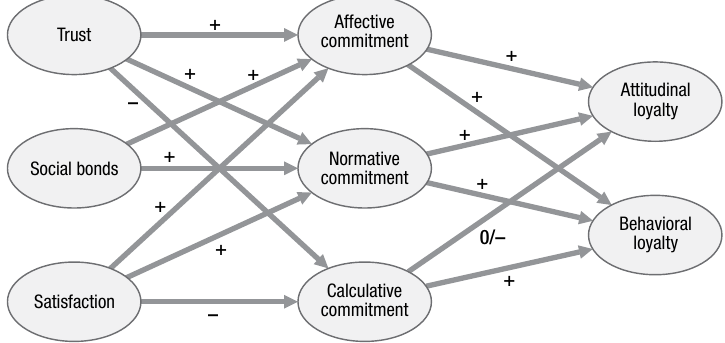
Fig. 1. Proposed conceptual model of commitment based on the RM